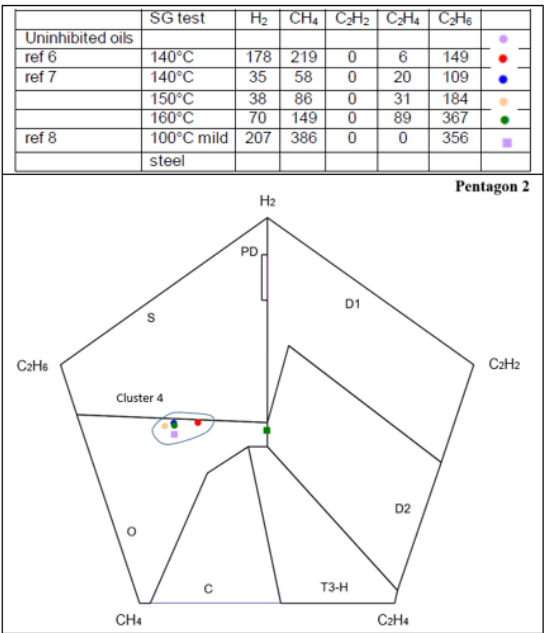
Figure 8. SG of uninhibited mineral oils other than oil B during the SG tests (T > 140 °C) by laboratories other than the FKH, in Cluster 4.